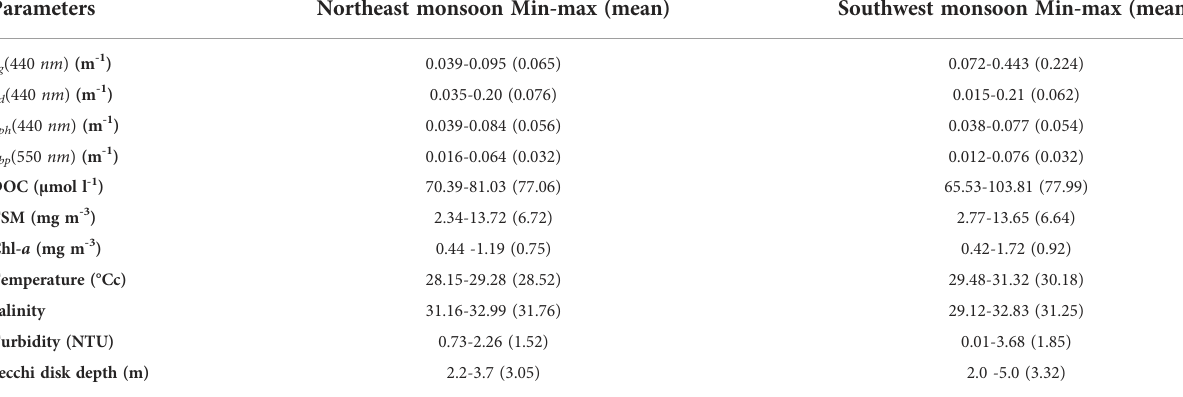
TABLE 1 Summary of in S.G. situ acquired IOPs and optically active constituents at Singapore Strait at standard